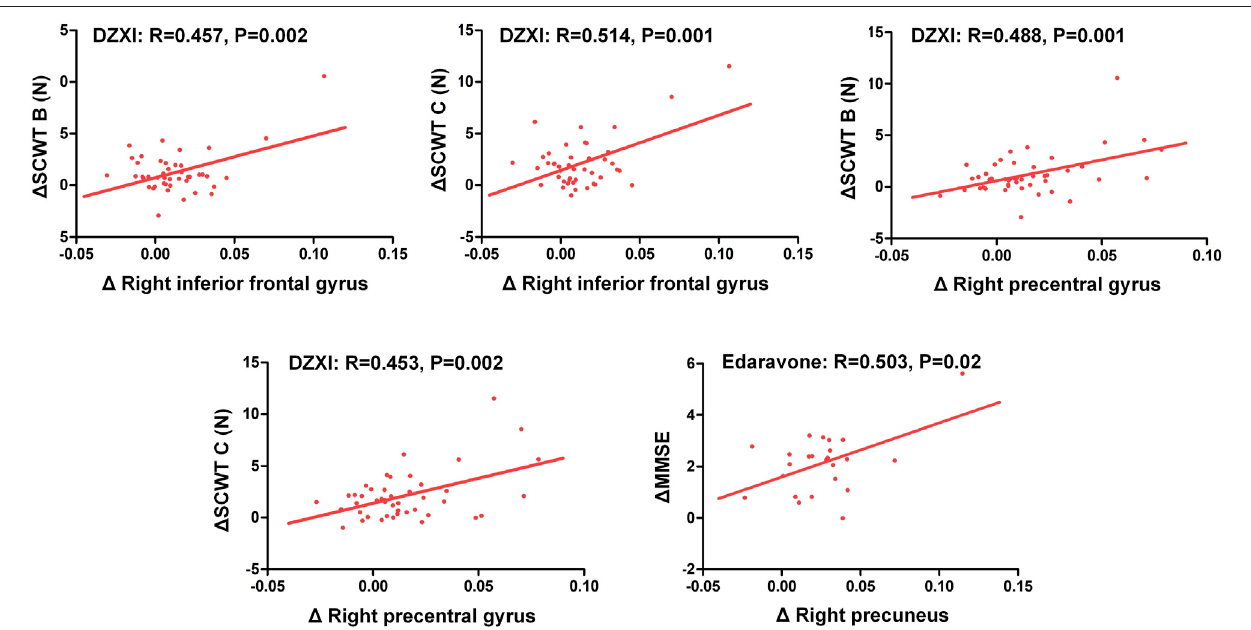
FIGURE3| Improvementsinthecognitivede fi citsofAISpatientswereassociatedwithincreasedgrey mattervolumes inspeci fi cregionsafter treatment withDZXI and edaravone. The association between changes in neuropsychological test scores and that in grey matter volumes of speci fi c regions were analyzed with a partial correlationanalysis,withage,gender and yearsofeducationserving asthecovariates. n (cid:2) 42inDZXIgroupand 24inedaravonegroup. Δ , theincrementsintest scores or grey matter volumes at 14th day of treatment from the baseline.